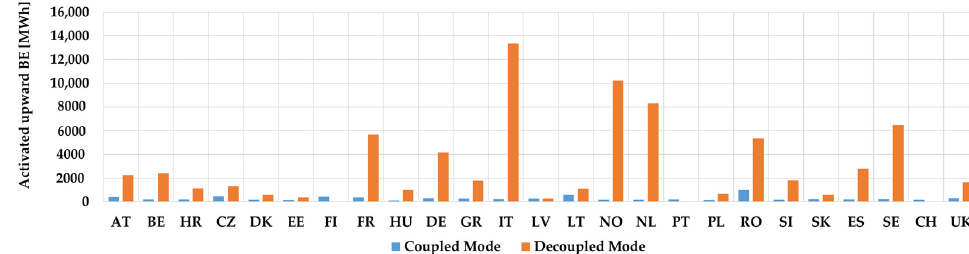
Figure 15. Activated upward BE in each participating control area.